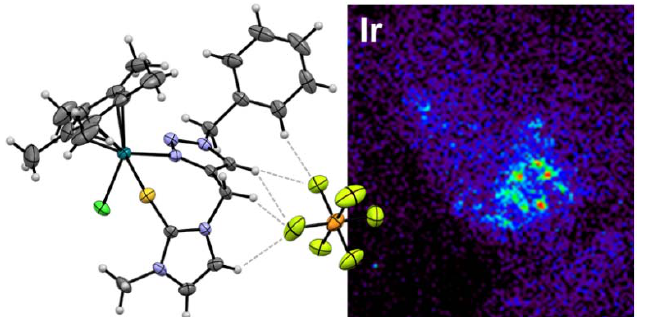
Figure 1. The molecular structure of one of the chelated thiourea enantiomers found ( left ) and Ir distribution in SKOV-3 cancer cells after treatment as determined by X-ray fluorescence microscopy ( right )